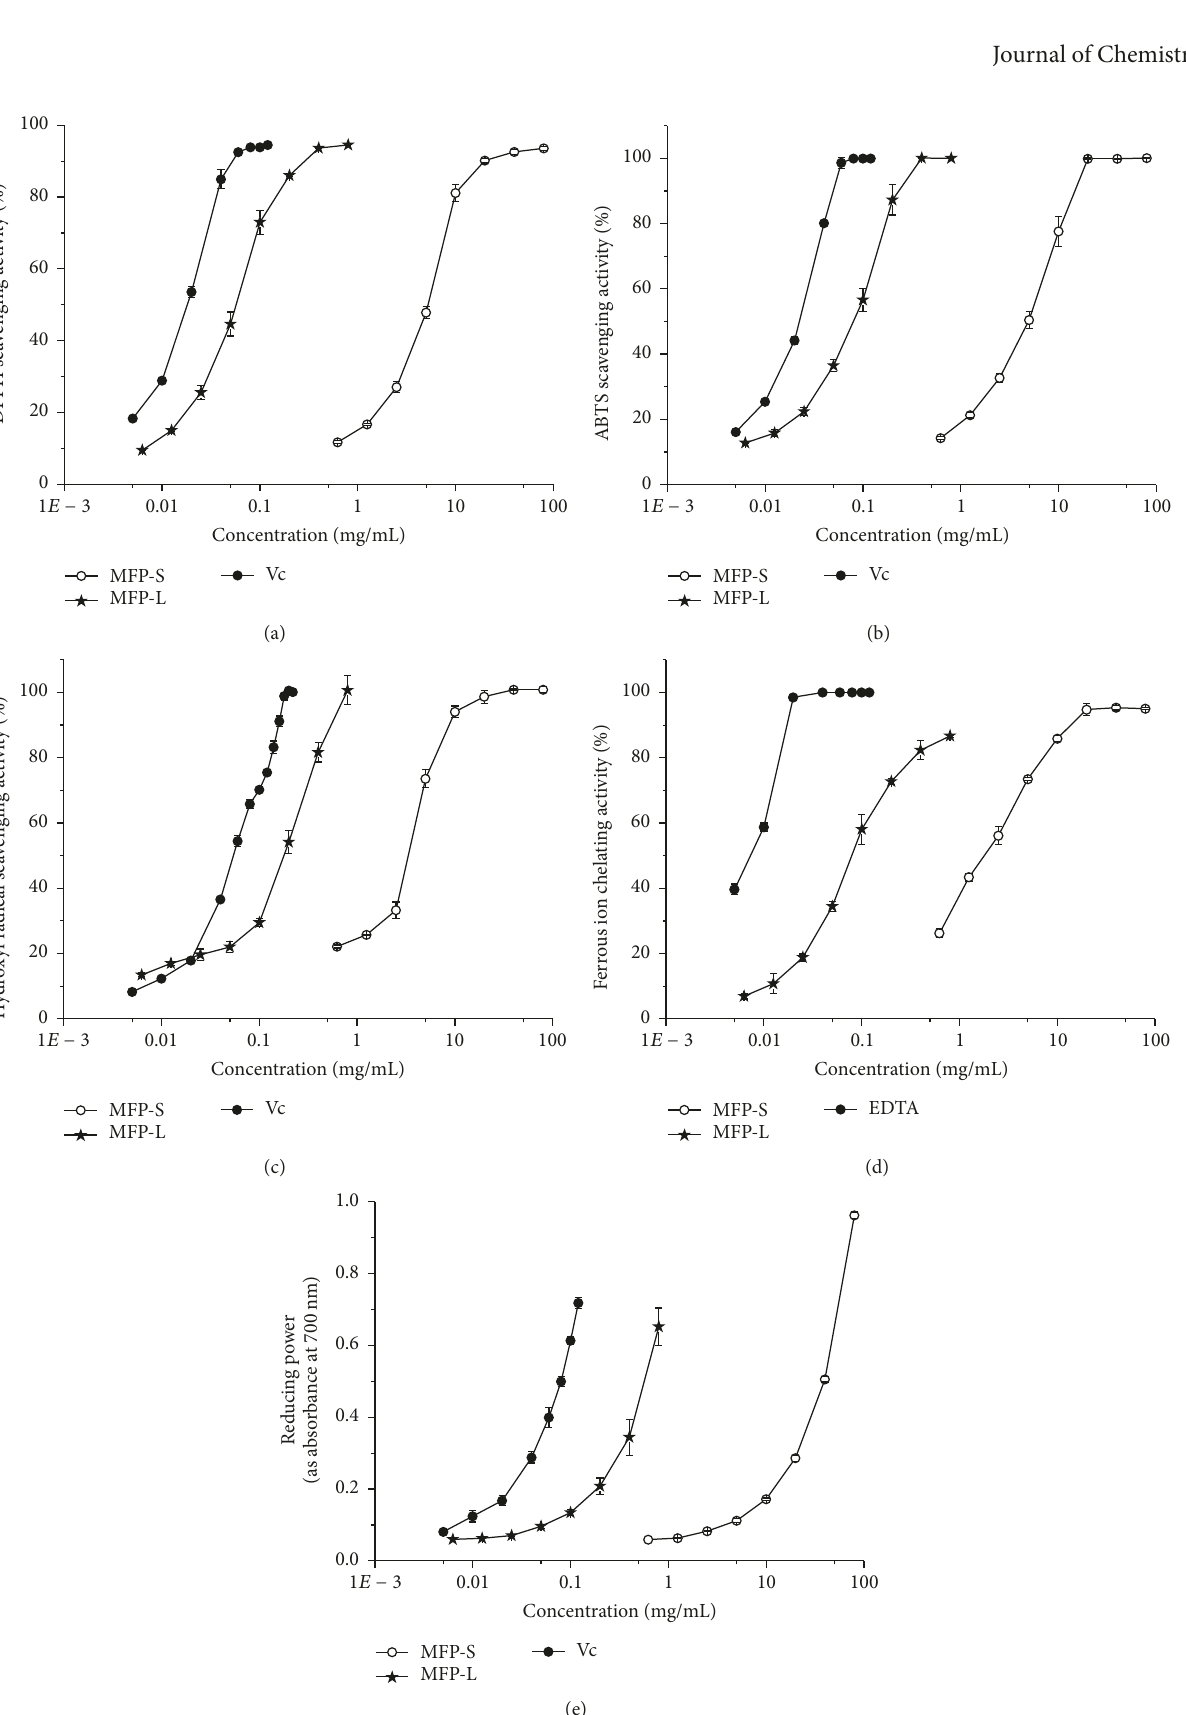
Figure 4: Antioxidant activities of MFP-S and MFP-L in vitro. DPPH (a); ABTS (b); hydroxyl radical scavenging activity (c); ferrous ion chelating activity (d); and ferric-reducing antioxidant power